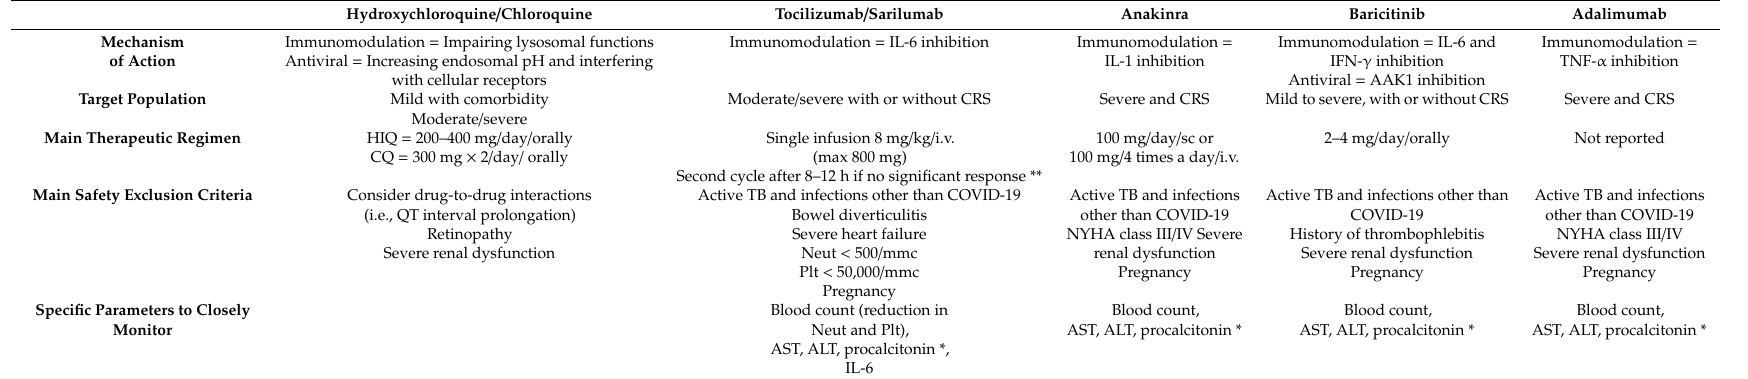
Table 1. Anti-rheumatic immunological drugs currently tested in clinical trials of COVID-19